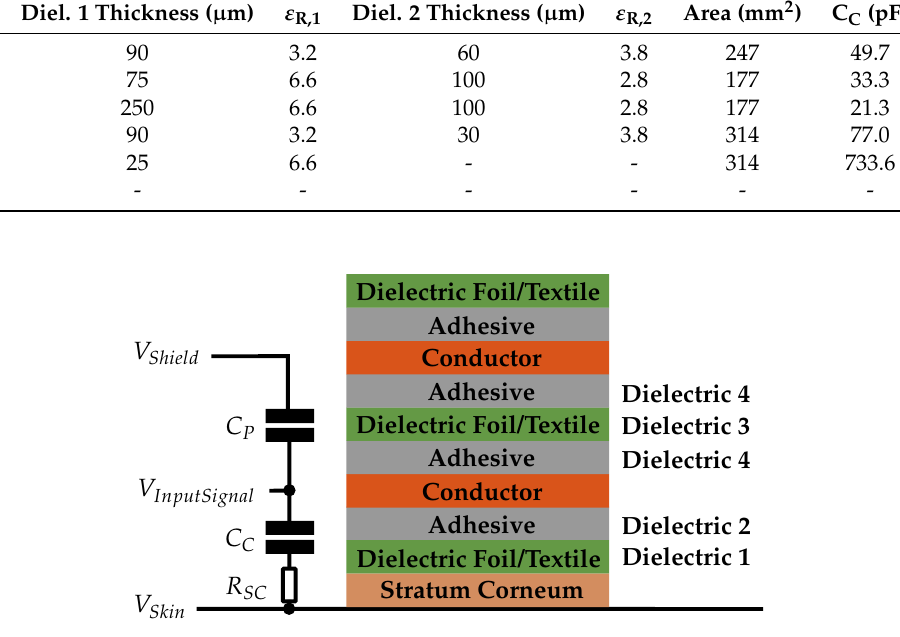
Figure 11. Stacking of the sensor assemblies in detail. The adhesives are silicone or acrylic adhesive and are not included in all sensor assemblies, as described in Section 3.1.1. The parameters of the dielectrics are listed in Table 2.